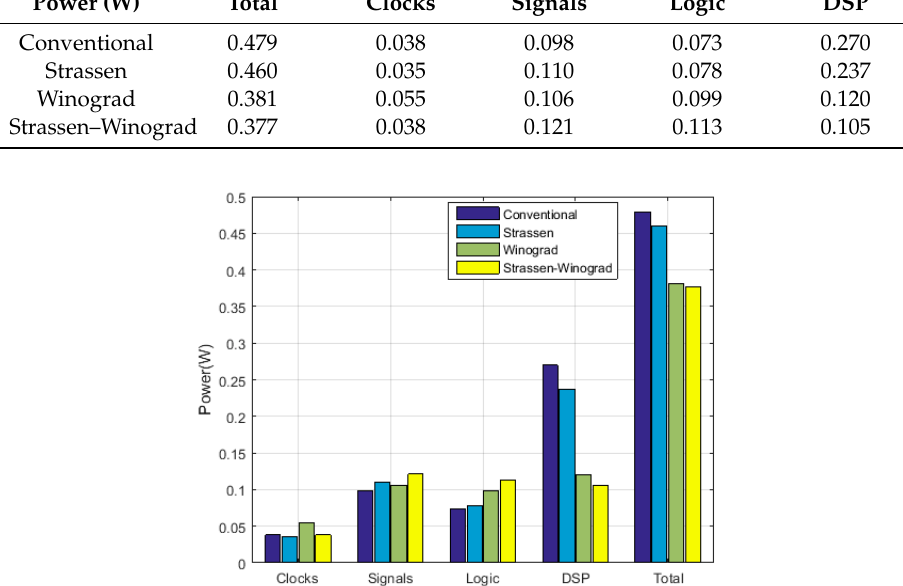
Table 2. Device utilization summary.